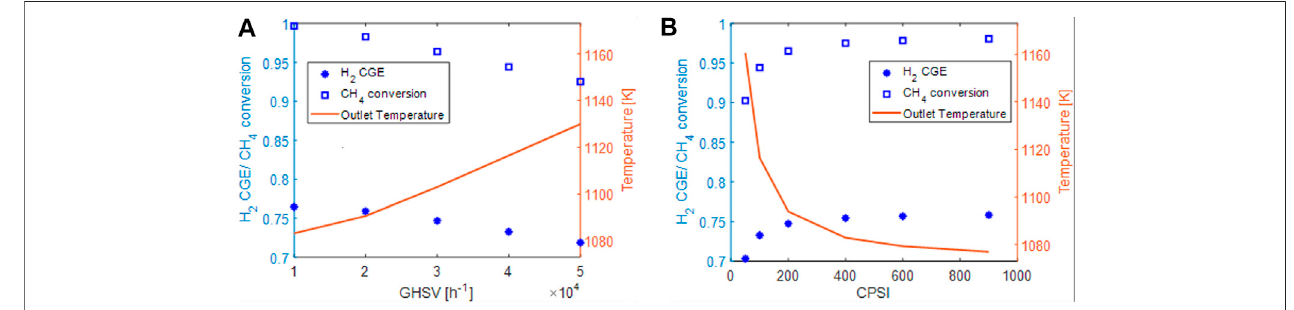
FIGURE 5 |(A) effect ofspace velocity on conversion (blue squares), Hydrogen cold gasef fi ciency (blue asterisks) and outlet solid temperature (red line). (B) effect of the CPSI on conversion (blue squares), Hydrogen cold gas ef fi ciency (blue asterisks) and outlet solid temperature (red line).